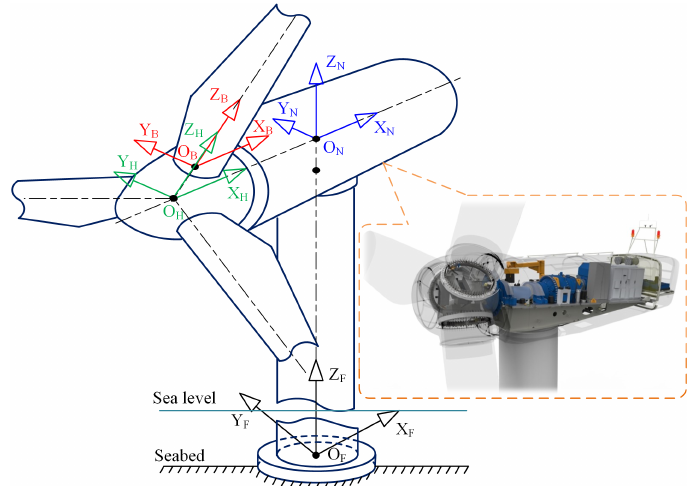
Figure 1. Structure and coordinate system of wind